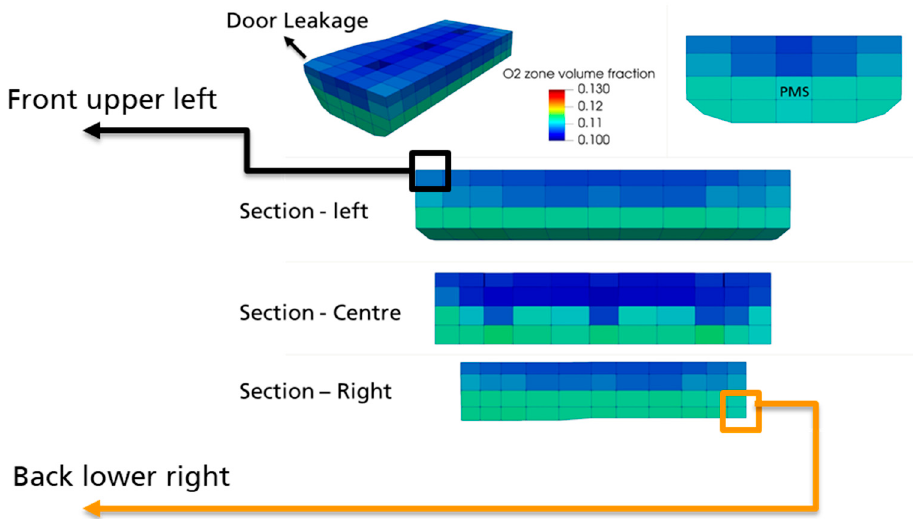
Figure 8. Left : Comparison of measured (bold) and simulated (dotted) oxygen concentrations. Right : Oxygen concentra- tion difference between the extremities.